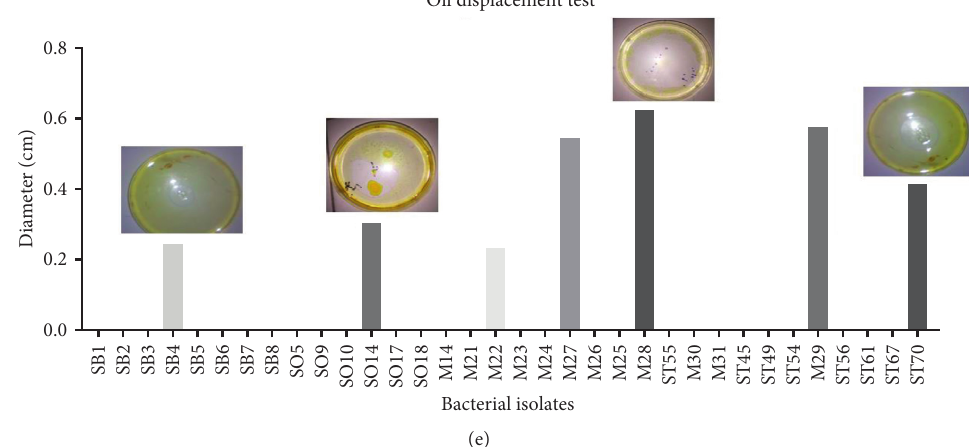
Figure 2: Emulsification activity of Bacillus isolates with gasoline (a), diesel oil (b), hexane (c), and benzene (d). Diameters of oil dis- placement test for the different isolates (e). Bacillus species isolates are SB1, SB2, SB3, SB4, SB5, SB6, SB7, SB8, SO5, SO9, SO10, SO14, SO17, SO18, M14, M21, M22, M23, M24, M25, M26, M27, M28, M29, M30, M31, ST45, ST49, ST54, ST55, ST56, ST61, ST67, and